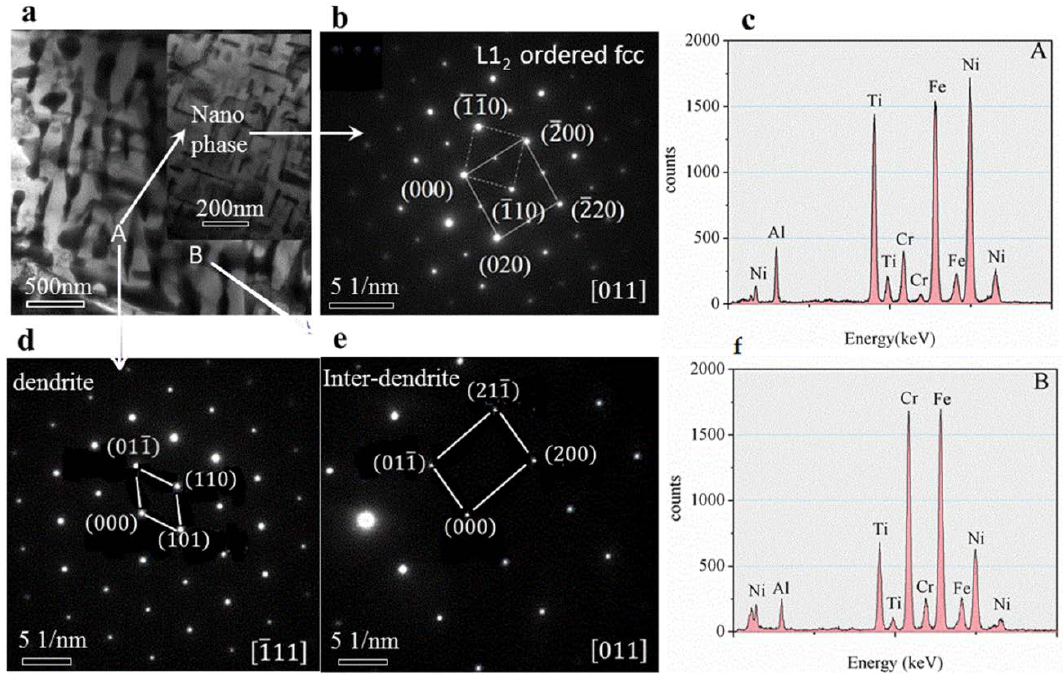
Figure 8. ( a – c ) TEM microstructures and Nano phase, ( d , e ) The selected area electron diffraction (SAED) pattern from dendrite and Inter-dendrite, respectively. ( f ) EDS energy spectrum.